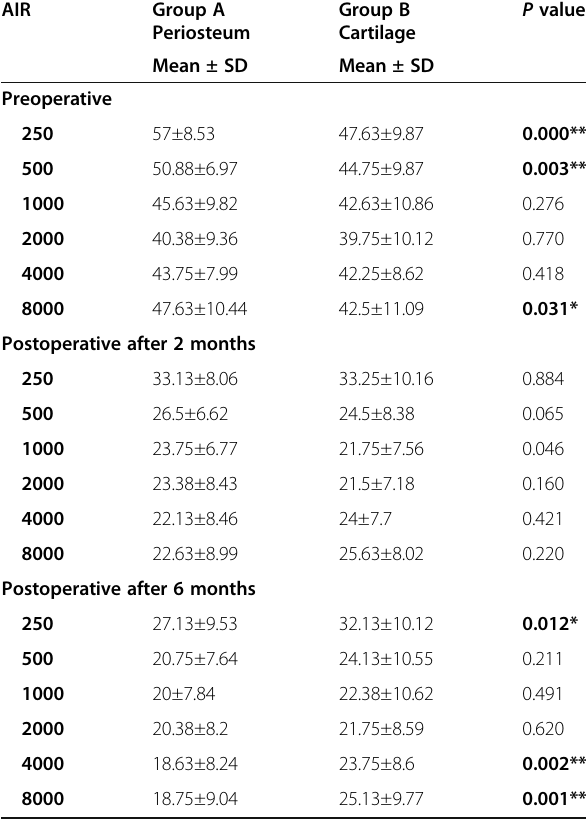
Table 2 Preoperative audiometry and 2 and 6 months follow-